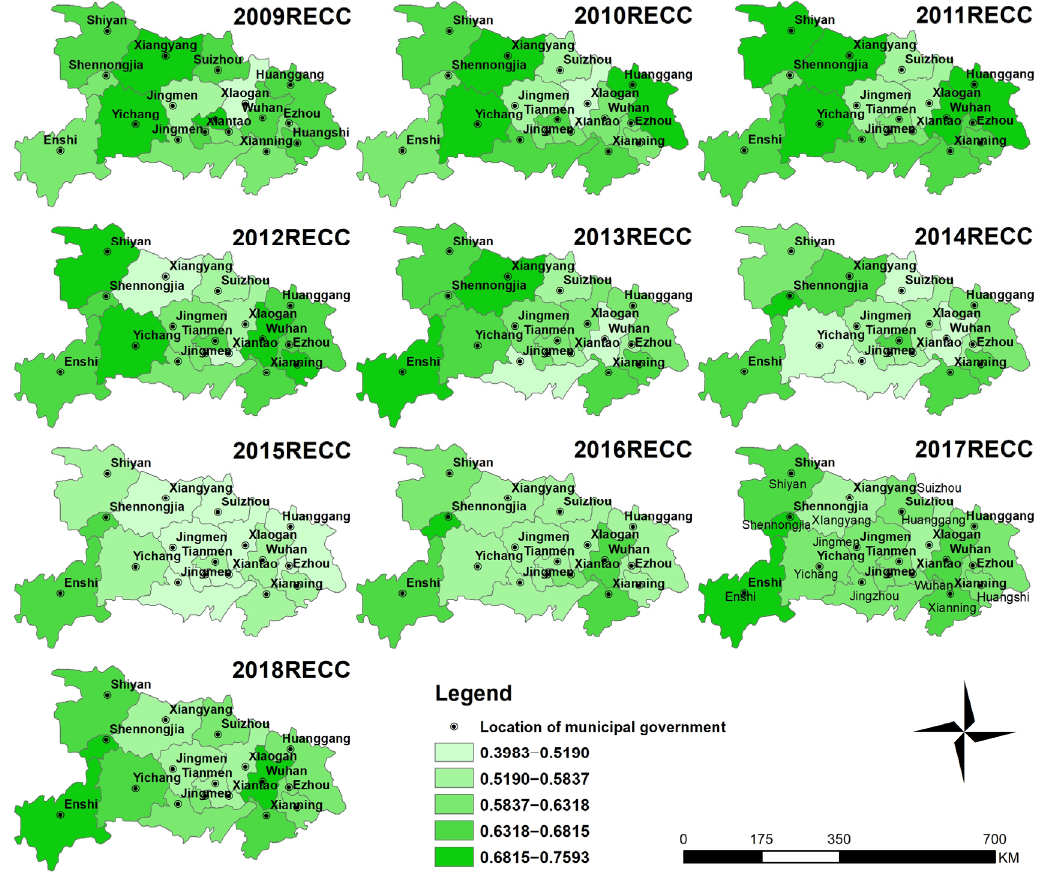
Figure 4. The spatial distribution of RECC in Hubei Province during